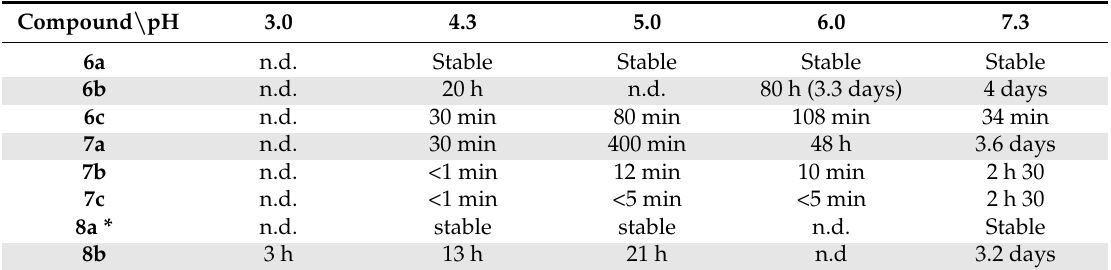
Table 1. Half-lives of compounds 6a–c , 7a–c , and 8a–b as a function of pH.